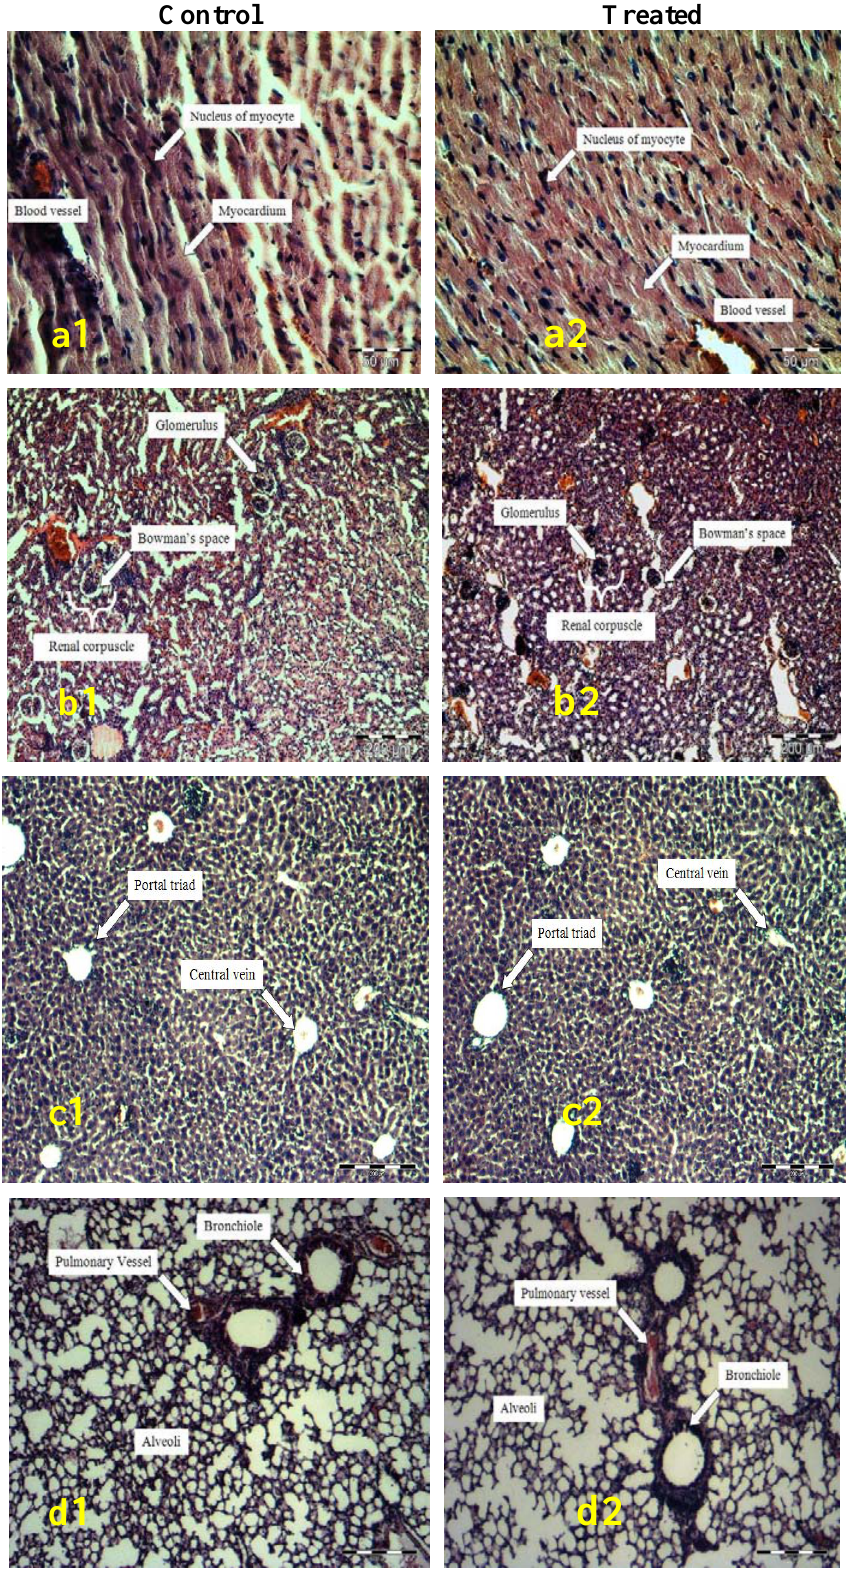
Figure 1. Histological examination of heart (a), kidneys (b), liver (c), lung (d), spleen (e) and ribcage